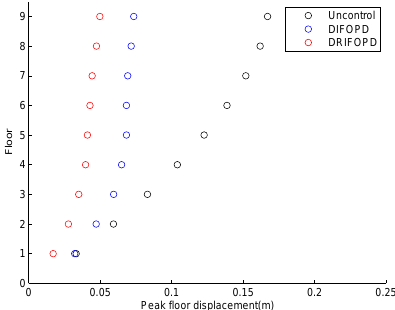
Figure 12. Maximum displacement of each floor under fault case 1.